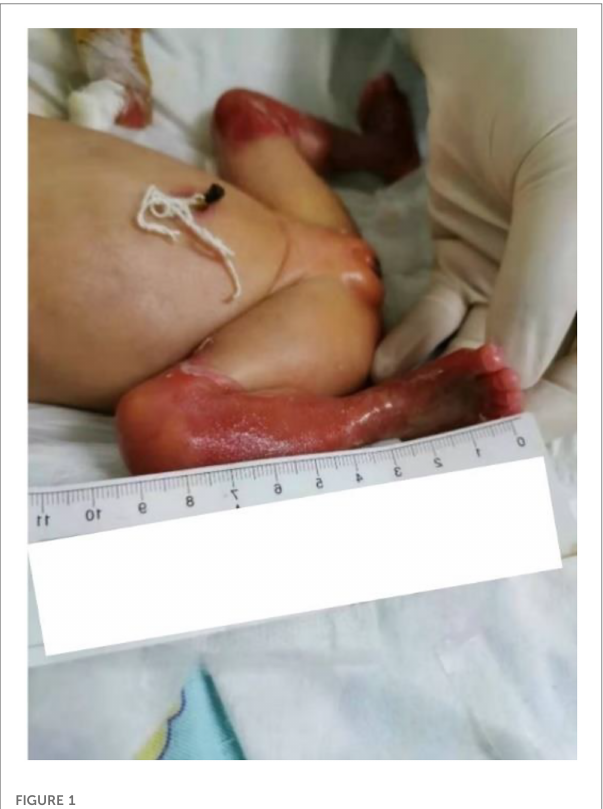
FIGURE 1 Severe ruptured blisters with skin lesions on both lower